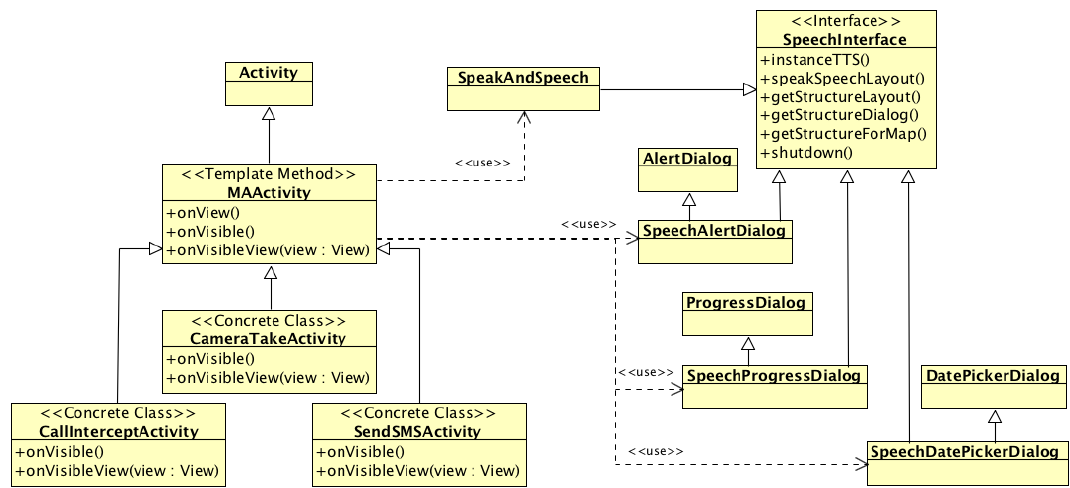
Figure 5. The Class Diagram of MicroApp components with speech capabilities.